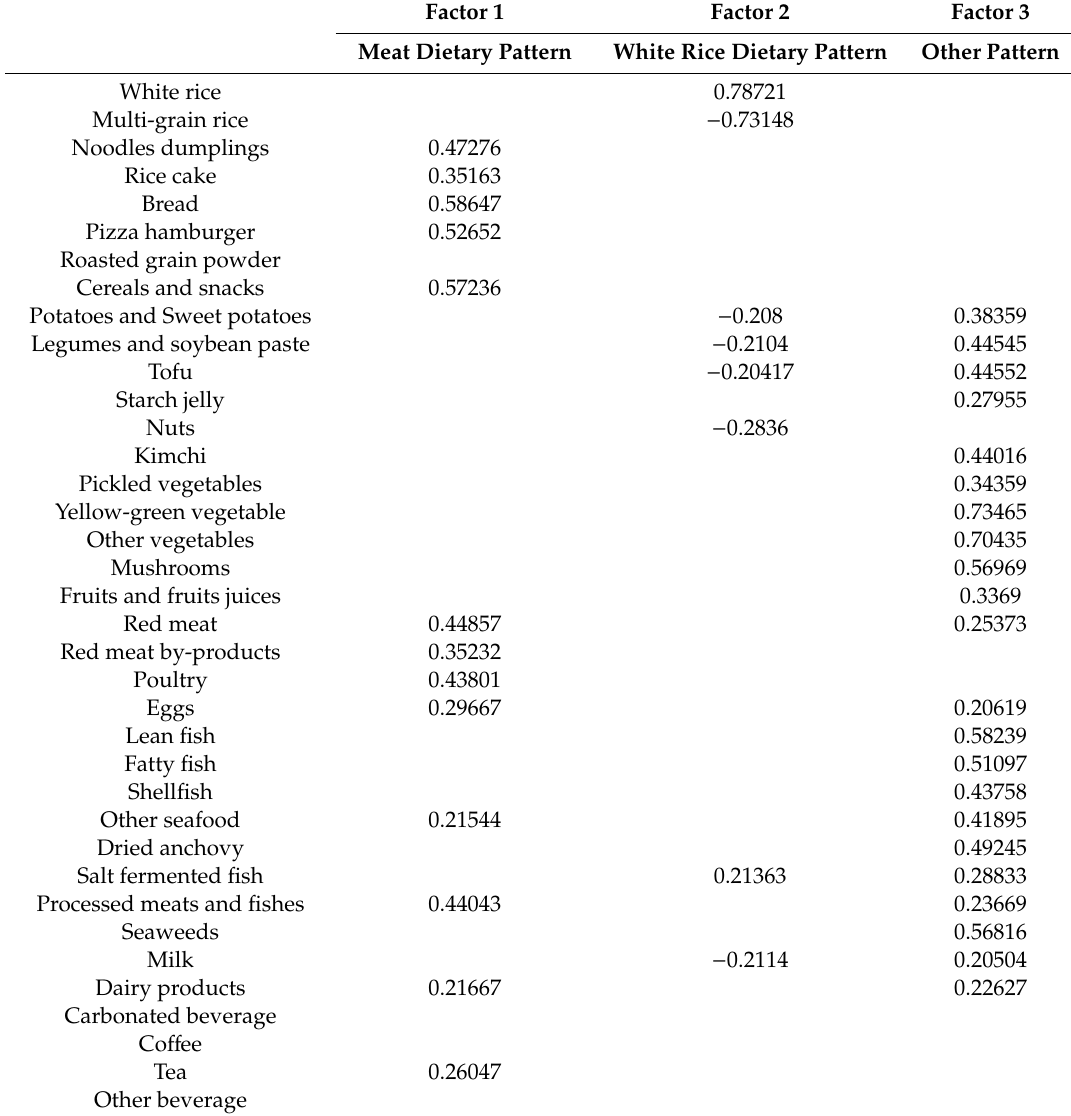
Table 2. Rotated Factor Loadings for Dietary Patterns Identified by Factor Analysis